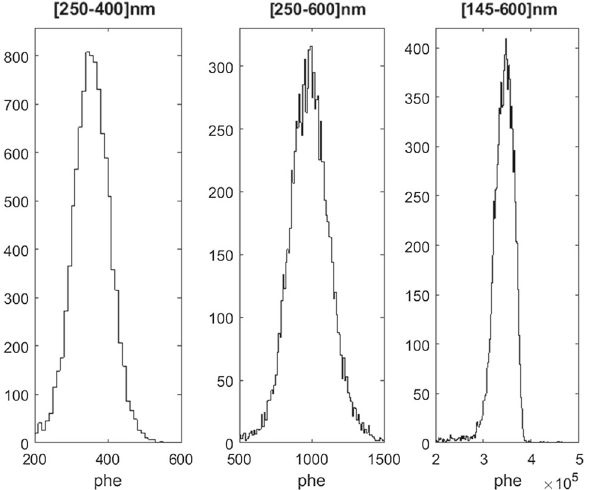
Fig. 17 Example of photoelectron distributions obtained for the sec- ondary scintillation of α -tracks at a pressure of 10 bar, with 4.0 kV applied at the anode and 50 V/cm/bar in the drift region